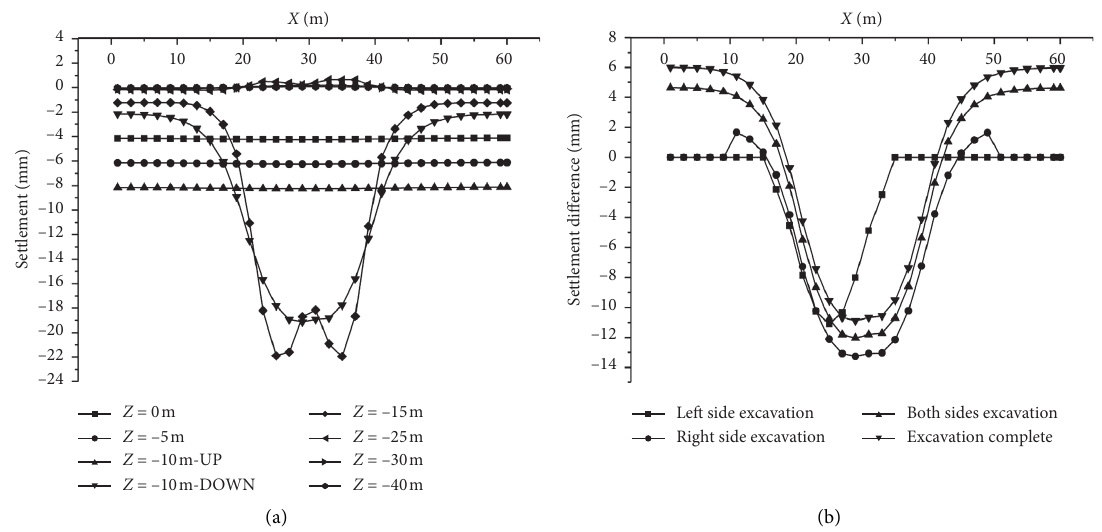
Figure 9: Settlement curve. (a) Settlement of different depths; (b) settlement difference of each step.